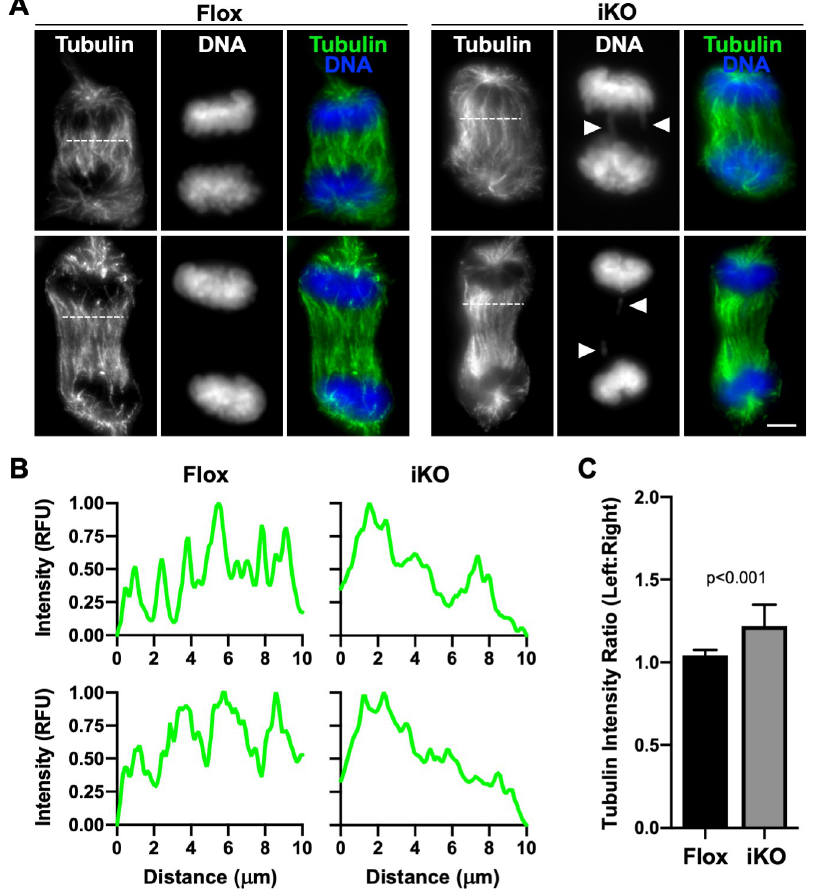
Fig 7. Anaphase microtubule organization is unbalanced in ArpC2 iKO cells. (A) Mouse fibroblasts were treated with DMSO (Flox) or 4-OHT (iKO) for 1d, fixed, and stained with a tubulin antibody (green) and DAPI (DNA; blue). Arrowheads highlight sites of aberrant chromatin localization. Scale bar, 5 μ m. (B) Line-scan plot profiles depict the pixel intensity of tubulin along the horizontal dashed lines drawn across the representative mitotic spindles from panel A. RFU = Relative Fluorescence Units. (C) Lines drawn perpendicular to the dashed lines were used to divide anaphase central spindles into left and right halves for measuring fluorescence intensities of microtubules. Each bar represents the mean left:right tubulin intensity ratio ± SD of n = 16 anaphase